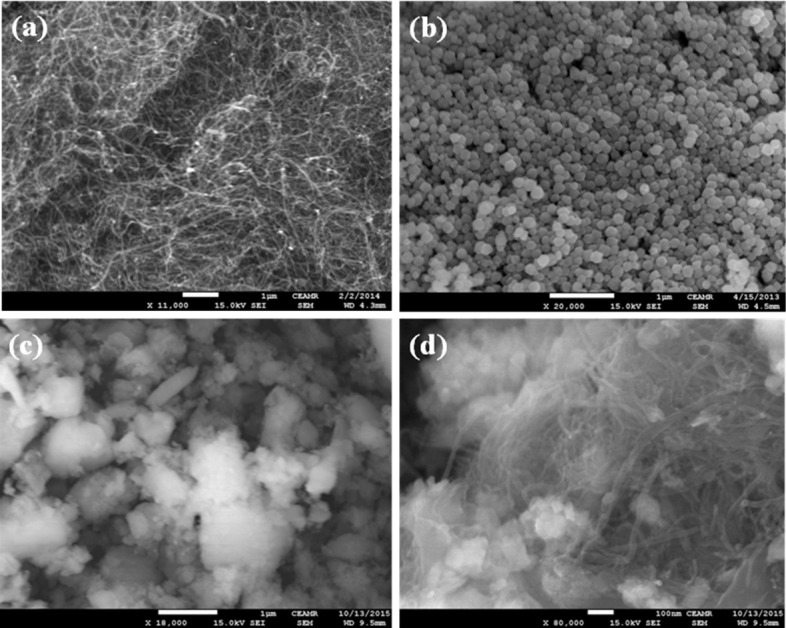
Magnified FESEM images (a) CNT, (b) Fe3O4 NPs, and (c-d) Fe3O4.CNT NCs.